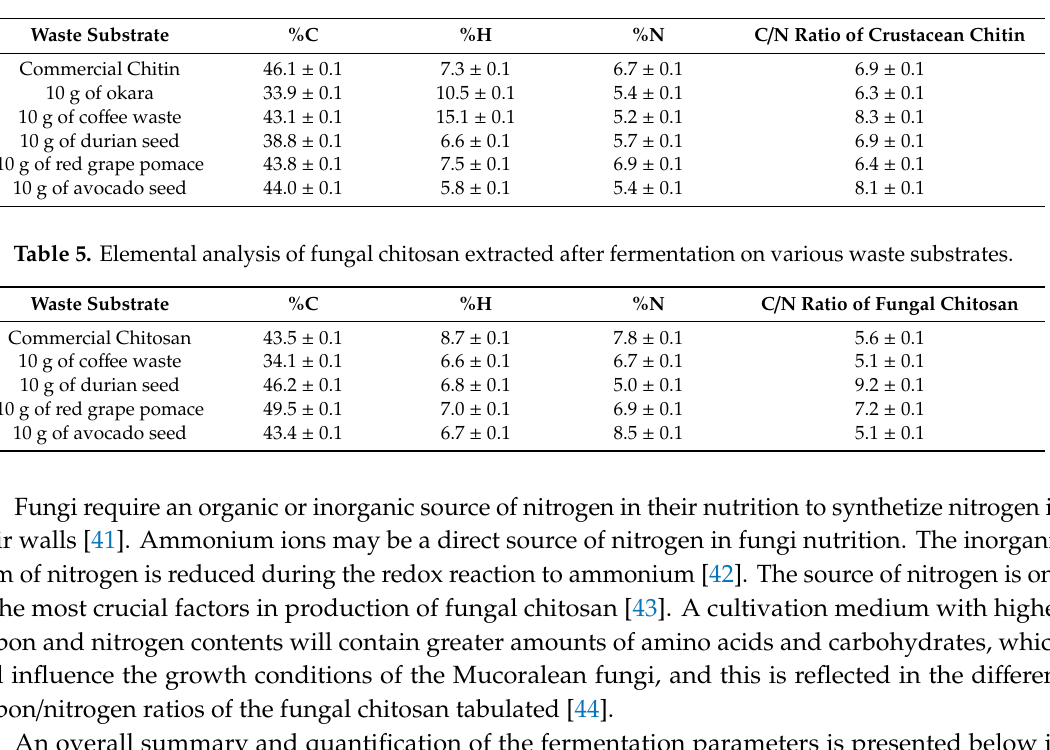
Table 4. Elemental analysis of crustacean chitin extracted after fermentation on various waste substrates.